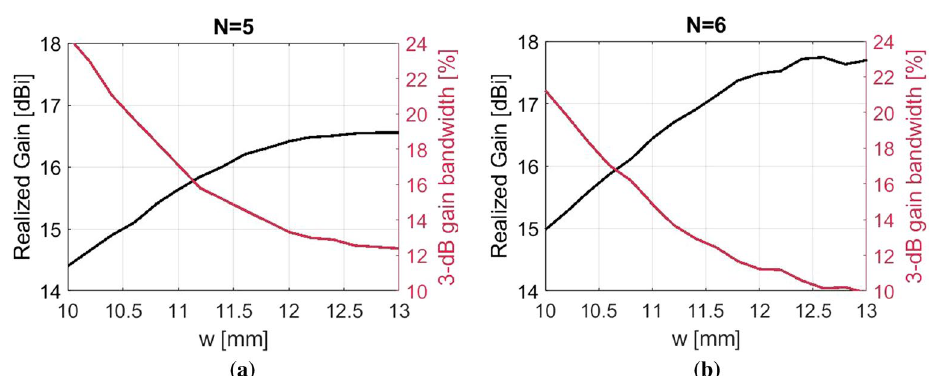
Figure 2. Simulation study over the relationship between gap width w , maximum realized gain and fractional gain bandwidth for a standard Bull’s Eye antenna of ( a ) N = 5 and ( b ) N = 6